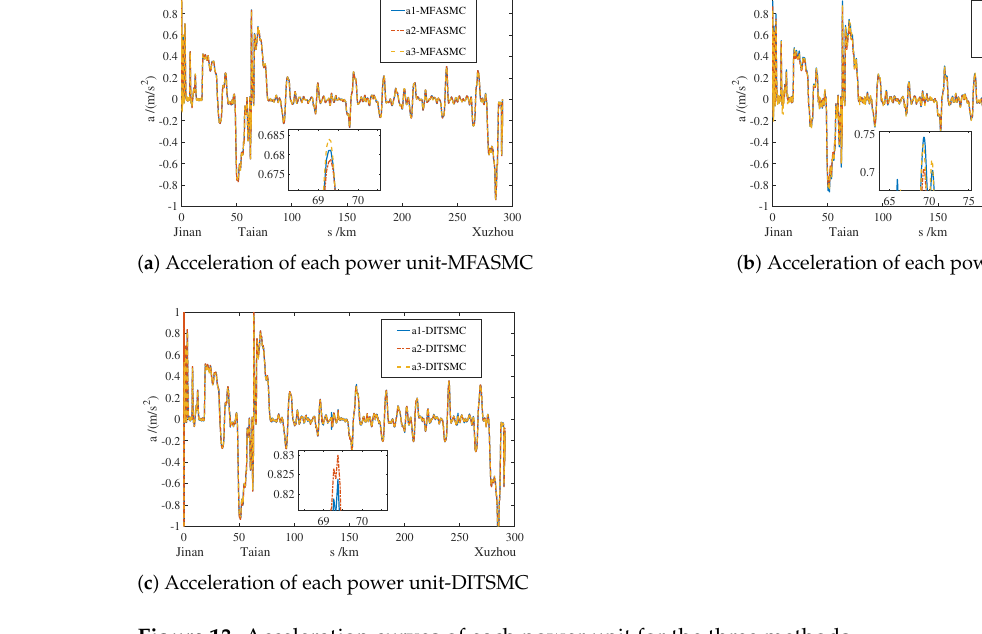
Figure 13. Acceleration curves of each power unit for the three methods.